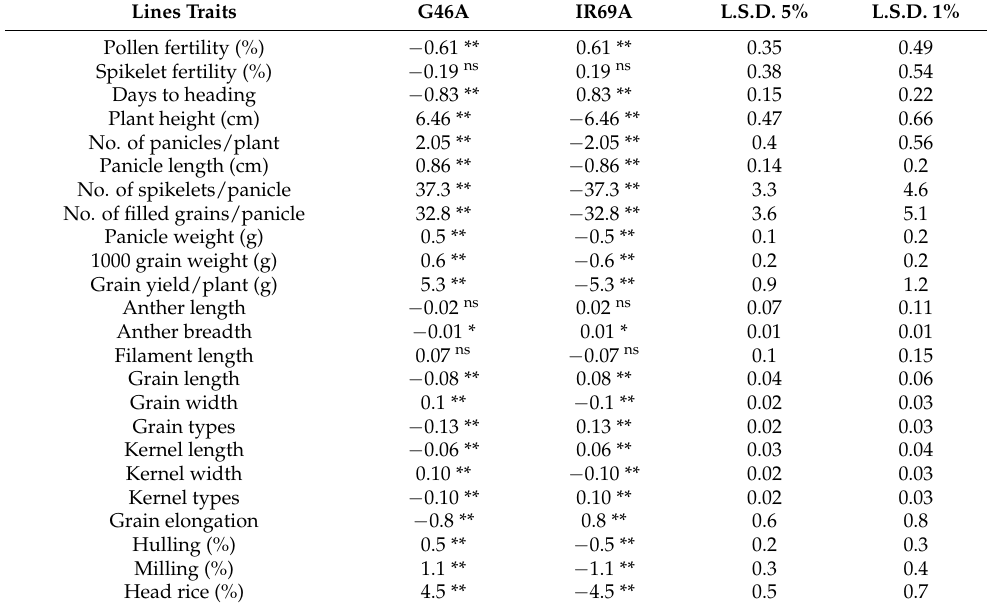
Table 4. General combining ability effects of the lines for the grain yield contributing traits, floral traits, and grain quality